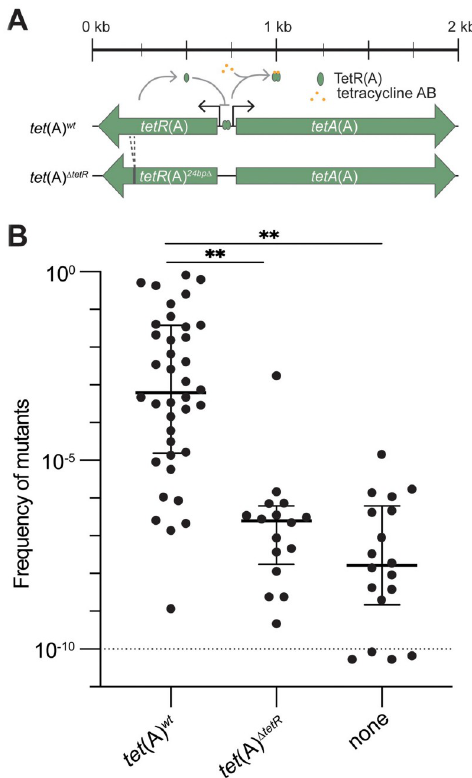
Fig 1. Relevant tet (A) alleles and frequencies of resistant mutants. ( A ) The tet (A) wt and tet (A) Δ tetR variants of tet (A), including a schematic of the regulation of tetA (A) by TetR(A). ( B ) Frequency of mutants determined by a simplified fluctuation assay at 0.5 mg/L TGC varies depending on tet (A) allele. Data points below dashed line (representing limit of detection) are not measured values but represent values below our limit of detection (about 1 × 10 − 10 ) for determining the mutant frequency of the isolate. Bars indicate median values and error bars represent the interquartile ranges. Isolates carrying tet (A) wt had a significantly higher frequency of TGC-resistant mutants than isolates carrying tet (A) Δ tetR or no tet (A) (Wilcoxon rank sum test, p < 0.0001 ( �� )). The underlying data can be found in S1 Data. TGC,